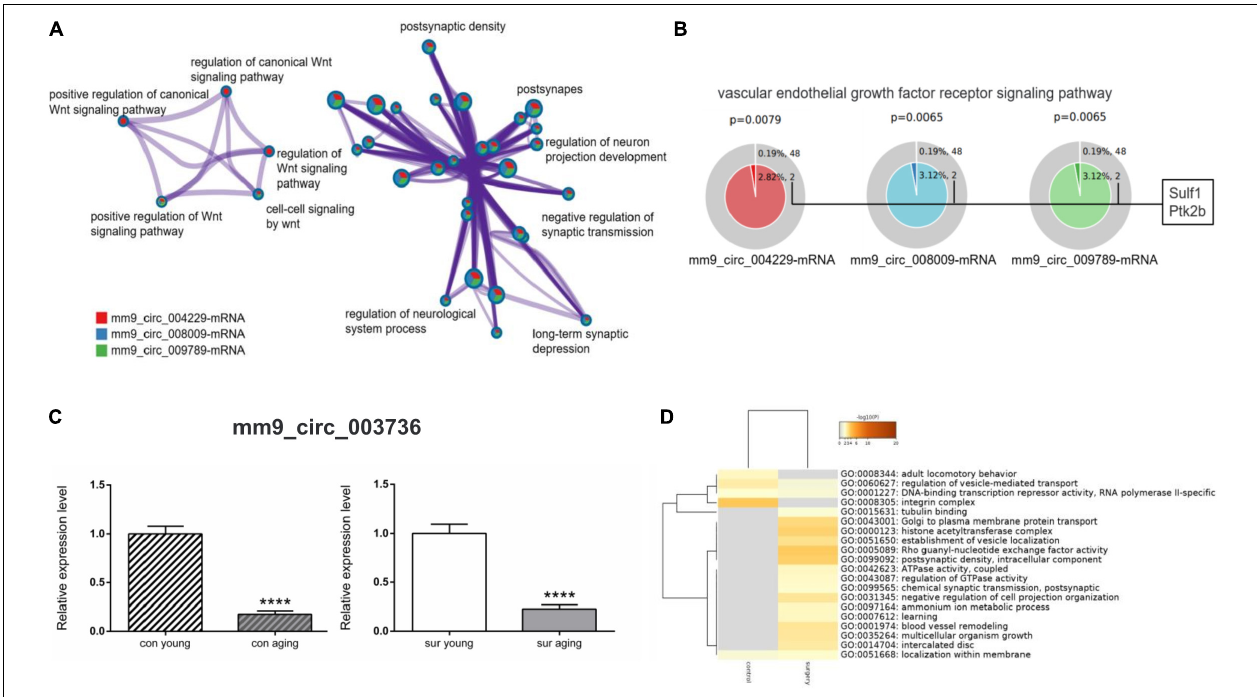
FIGURE 6 | Gene annotation and enrichment of target mRNAs in ceRNA networks. (A,B) The enrichment analysis of target mRNAs derived from mm9_circ_004229/mm9_circ_008009/mm9_circ_009789-associated-ceRNA networks [mm9_circ_004229-mRNA (red), mm9_circ_008009-mRNA (blue) and mm9_circ_009789-mRNA (green)]. (A) Enrichment network constructed by enriched terms. (B) Enriched GO term: “Vascular endothelial growth factor receptor signaling pathway” (GO:0048010). The term related mRNAs are as shown in the figure. P < 0.05 is considered as statistically significant. (C,D) The analysis of mm9_circ_003736-associated-ceRNA network. (C) Real-time qPCR to analysis the expression of mm9_circ_003736 in young and aging mice under control and anesthesia/surgery conditions. **** p < 0.0001. All data are presented as mean ± SEM ( n = 6). (D) The enrichment analysis of target mRNAs derived from mm9_circ_003736-associated-ceRNA networks under control and anesthesia/surgery conditions. Heatmap representing the differences between control and anesthesia/surgery conditions, colored by p -values, as shown in the legend above. The darker the color, the more statistically significant the term is. Gray indicates no enrichment in the corresponding term, P >